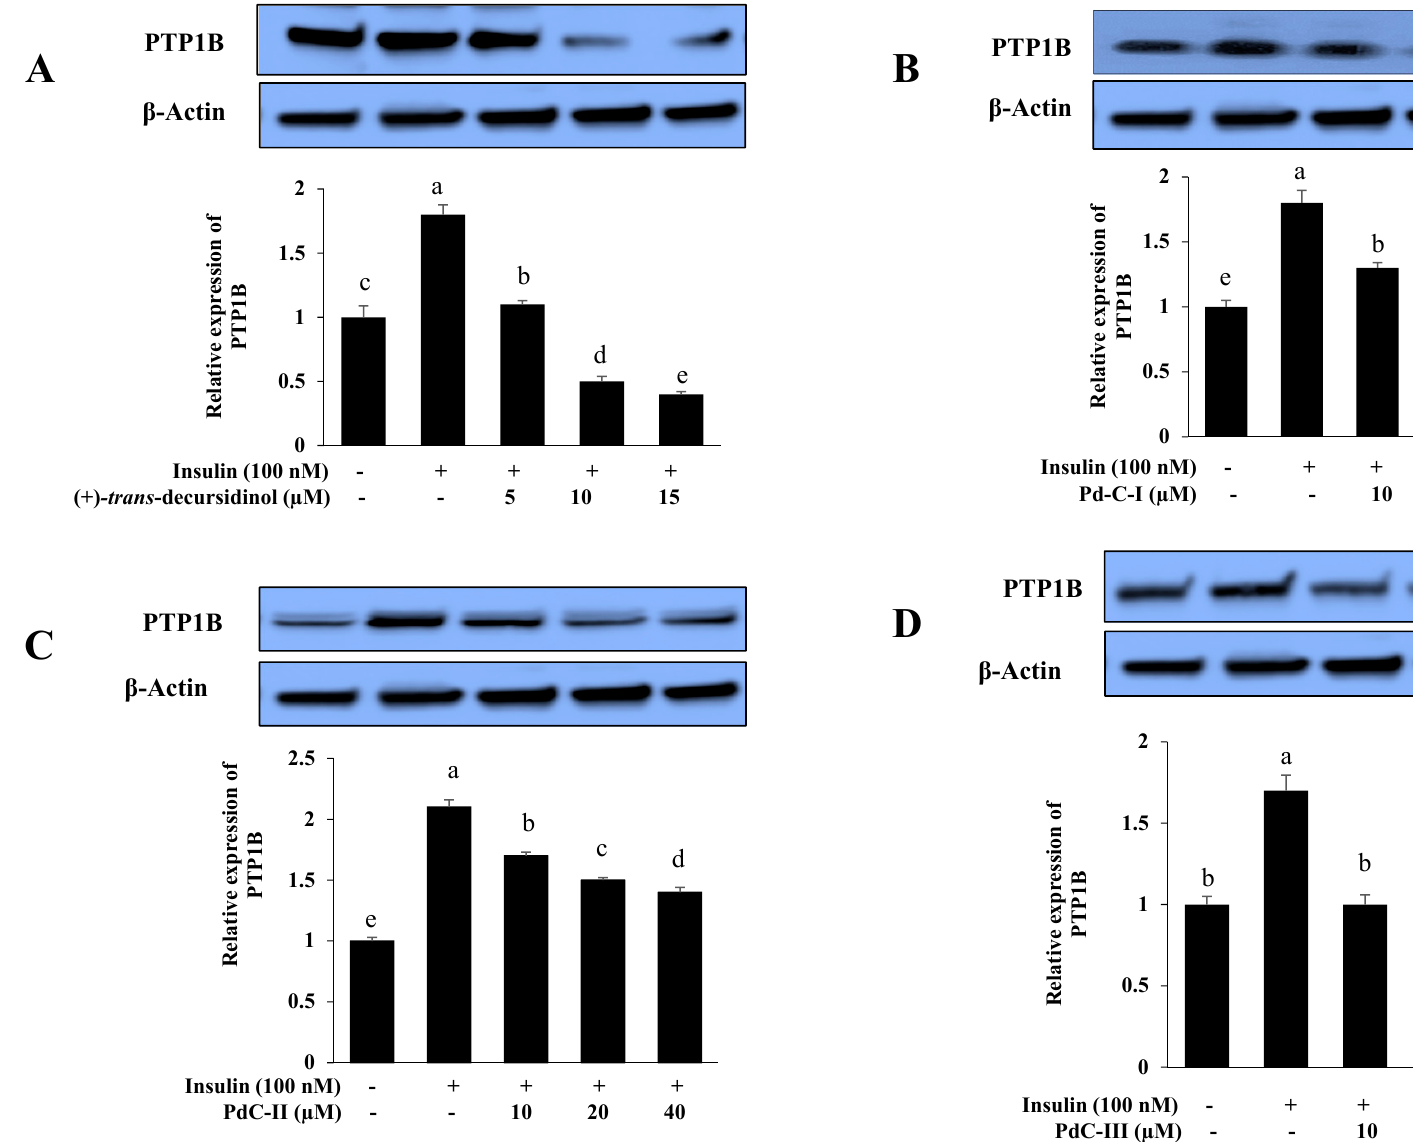
Figure 5. Effect of dihydroxanthyletin-type coumarins ( A – D ) on the levels of expression of protein tyrosine phosphatase 1B (PTP1B) in insulin-resistant HepG2 cells. Relative densities of PTP1B versus β -actin. The intensity of protein bands was quantified by densitometry. The results have been normalized versus β -actin levels and are described in three different experiments as the means ± SEMs. a–e Mean with different letters are significantly differences among means of dihydroxanthyletin-type coumarins concentration. Results were analyzed by ANOVA and Duncan’s test ( p <